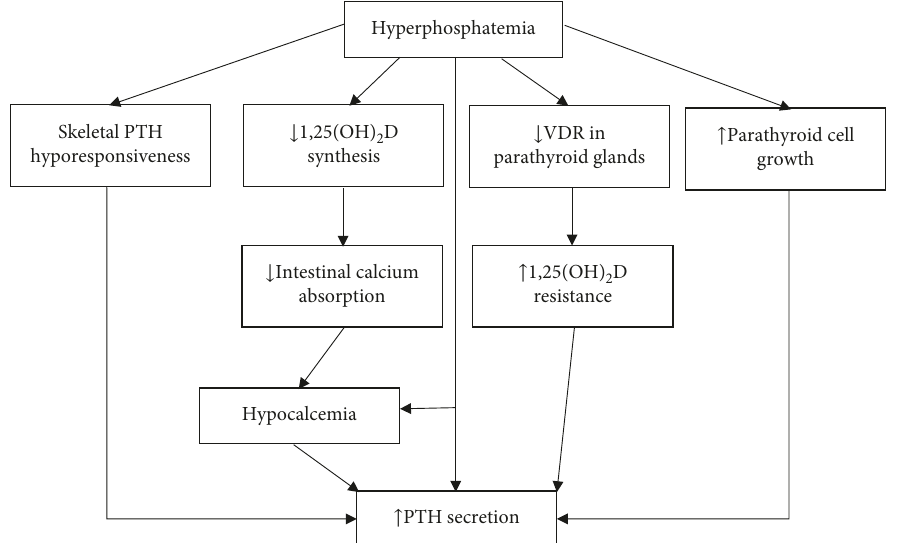
Figure 1: Mechanism of phosphate-induced secondary hyperparathyroidism. PTH, parathyroid hormone; VDR, vitamin D